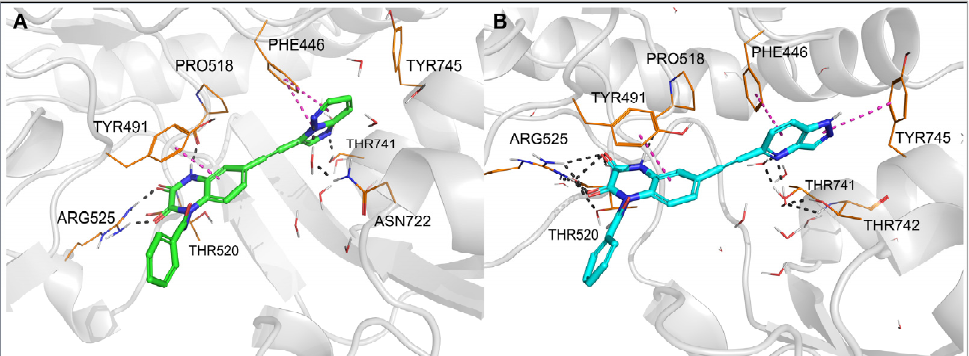
Figure 6. Complexes of the GluK3-LBD with compound 28 ( A ) and 29 ( B ) after 20 ns molecular dynamics simulation. Hydrogen bonds are marked with dark dashes, aromatic interactions are marked with pink dashes.